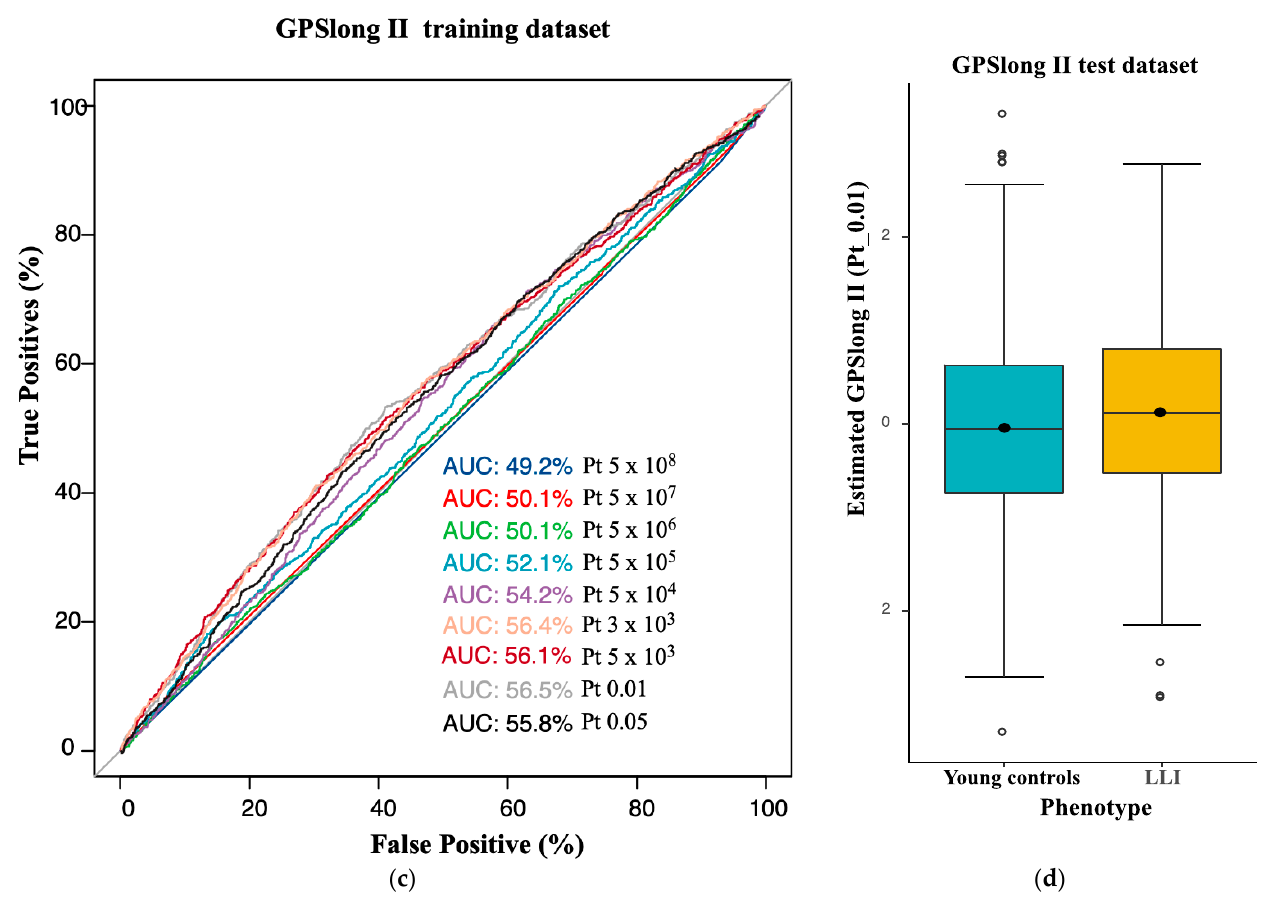
Figure 2. Longevity genome-wide polygenic scores (GPSlong and GPSlong II). ( a , c ) Discrimination potential of GPSlong ( a ) and GPSlong II ( c ) measured by the area under the curve (AUC) with different cut-offs. ( b , d ) Distribution of GPSlong ( b ) and GPSlong II ( d ) among the individuals. The values for LLI and younger controls in the test dataset are represented by boxplots. Pt denotes the different p -value significance cut-offs for the SNVs for GPS calculation.